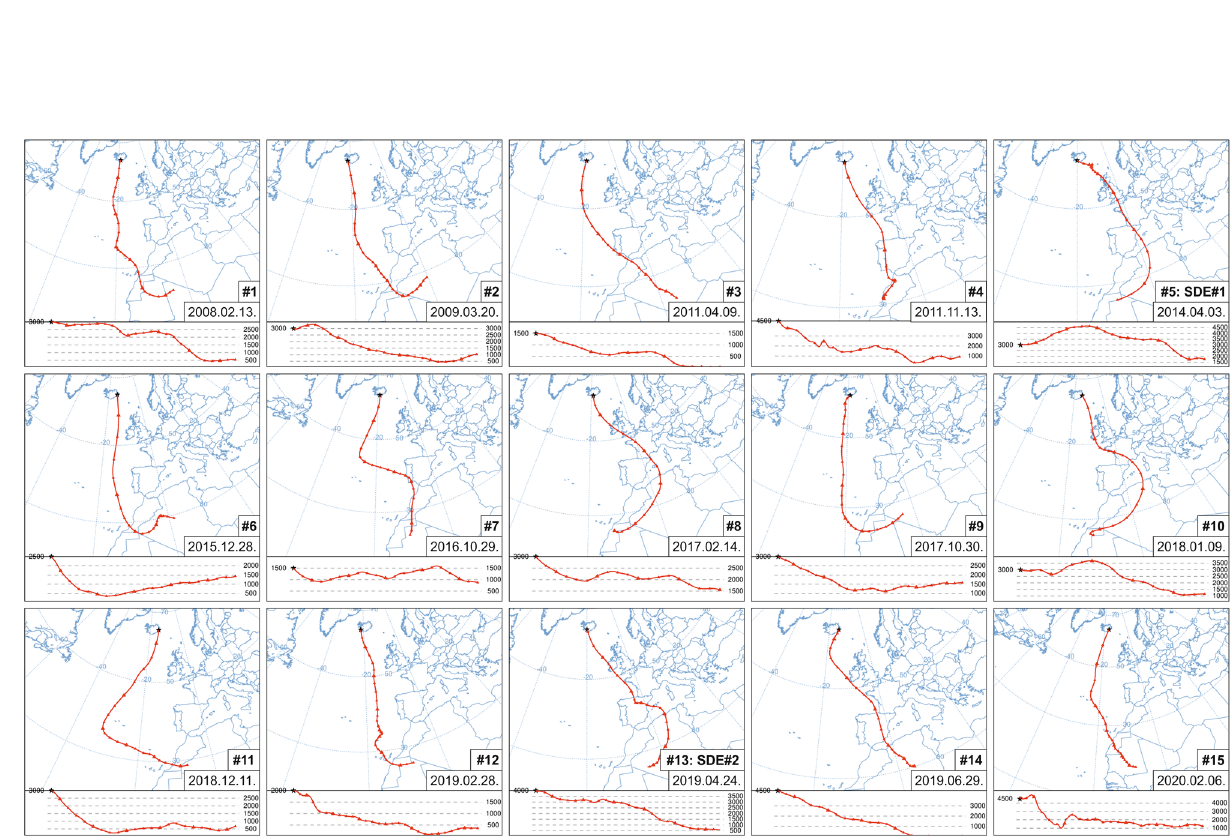
Figure 3. Backward trajectories (HYSPLIT model) of the identified Saharan dust events in